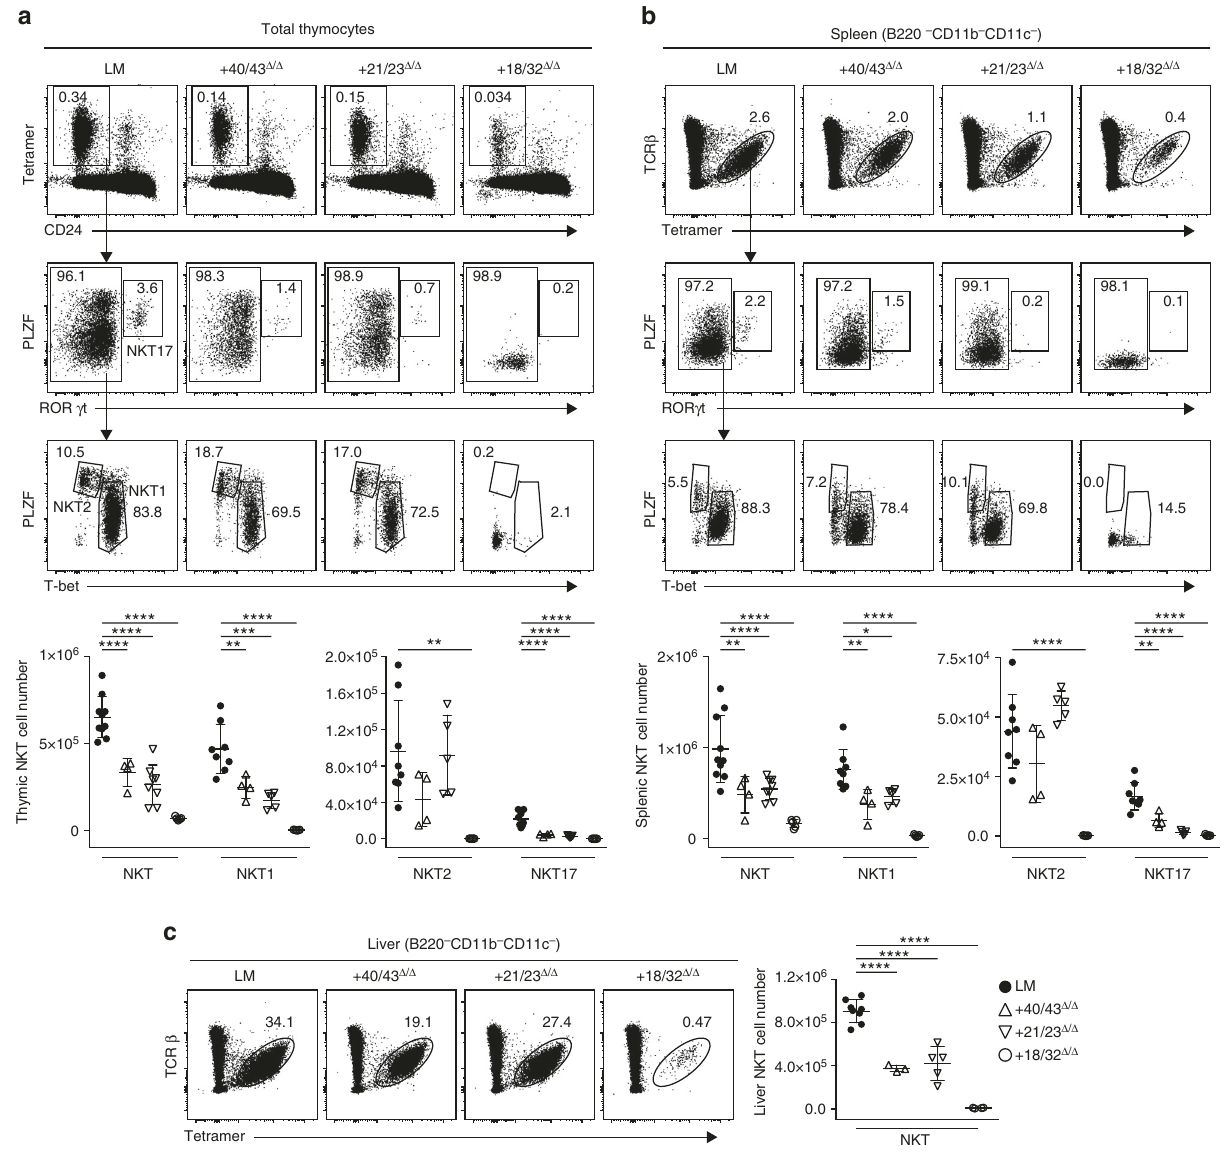
Fig. 4 Impact on NKT sublineages. Intracellular FACS staining of PLZF, T-bet and ROR γ t in a thymic and b splenic NKT cells in indicated mutant mice, with summary panels. c Analysis of liver NKT cells. Data are from four independent experiments, with 4 – 10 mice in each group. Statistical analysis was performed using one-way ANOVA for multiple comparisons to WT LM. * P < 0.05, ** P < 0.01, *** P < 0.001, **** P <